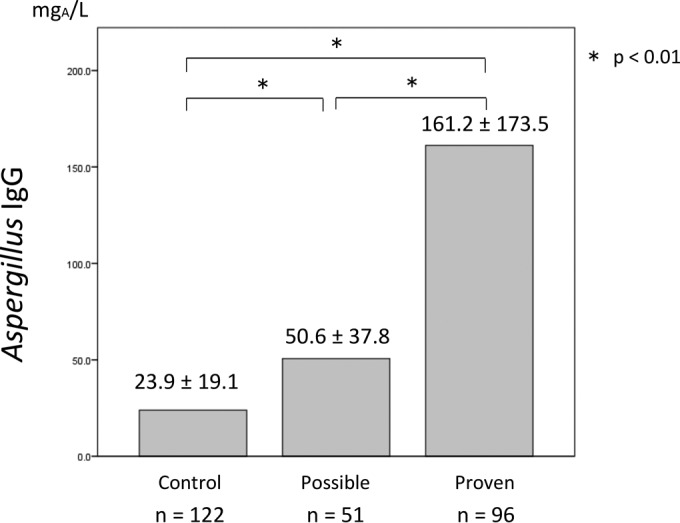
Average Aspergillus IgG level in serum from each group measured by fluorescent immunoenzyme assay. Data represent the means ± standard deviations (SDs). *, P value of <0.01.